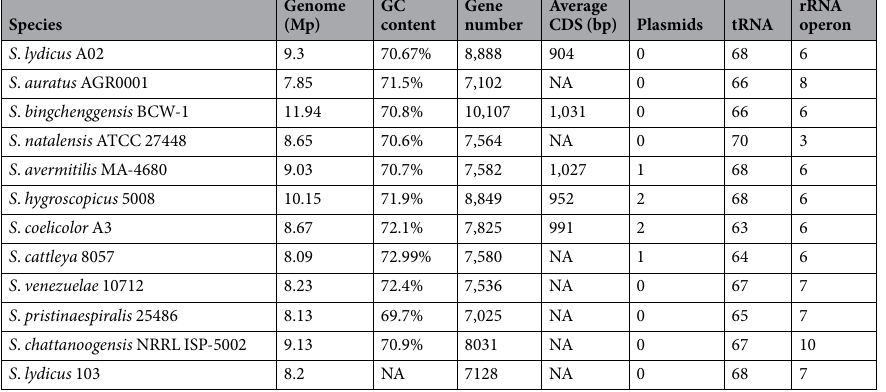
total of 68 tRNA-encoding genes and six rRNA operons (six 5 S rRNAs, six 23 S rRNAs and six 16 S rRNAs) were found in the linear chromosome. A comparative analysis was performed on the basic genome features of A02 and 11 previously sequenced Streptomyces strains (Table 2). The genome of S . lydicus A02 is smaller than the previously sequenced linear genome of S . bingchenggensis BCW-1 (11.9 Mbp) and S . hygroscopicus 5008 (10.15 Mbp) but larger than those of other Streptomyces strains 19–23 . However, it has a gene number that is lower than that of only S . bingchenggensis